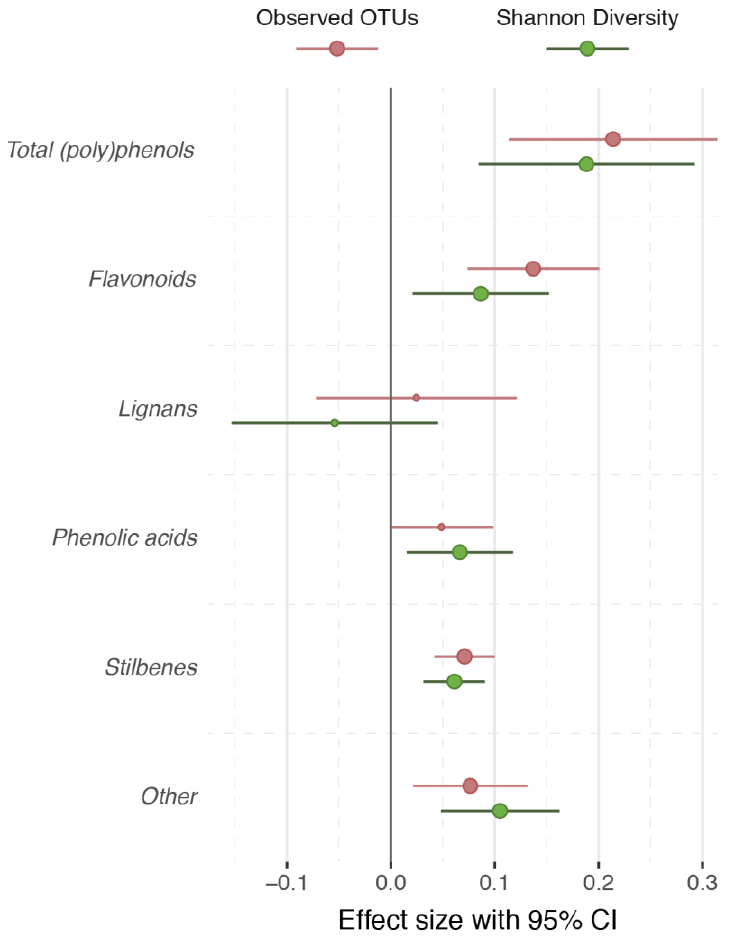
Figure 1. Dietary (poly)phenols and measures of gut microbiome alpha diversity in the TwinsUK cohort. Analyses were adjusted by age, BMI, dietary fiber intake, total energy intake and family relatedness. CI indicates confidence